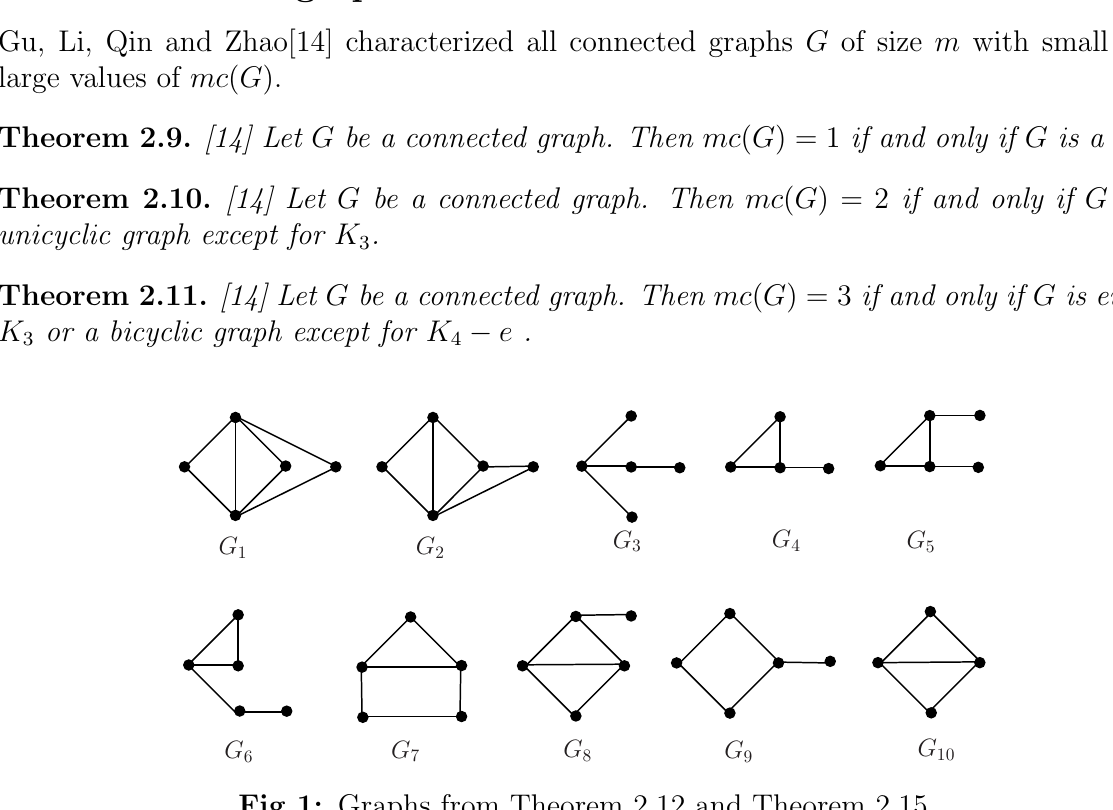
Fig 1: Graphs from Theorem 2.12 and Theorem